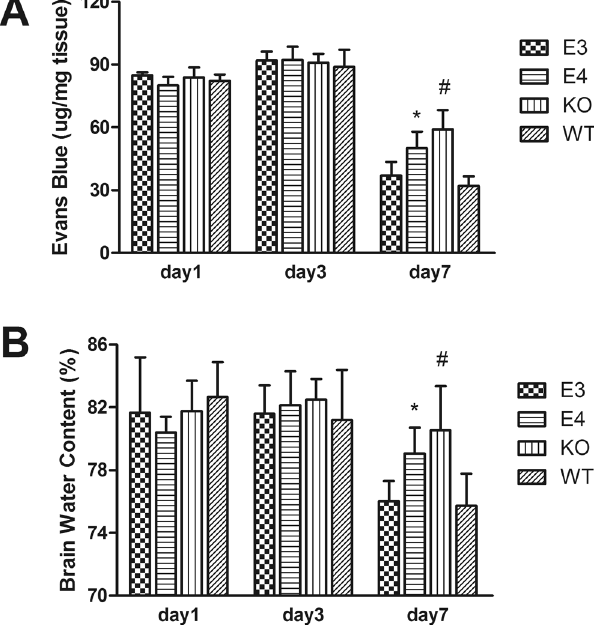
Figure 3. ( A ) BBB permeability was detected by EB extravasation after TBI, and no significant differences were observed in each group at day 1 or day 3. However, EB dye exudation significantly decreased in each group at day 7 and decreased more sharply in E3 and WT mice. ( * P < 0.05 vs E3 mice and P < 0.01 vs WT mice; # P < 0.01 vs WT mice. N = 8) ( B ) The brain water content significantly increased after injury. Consistent with the BBB permeability assay, at day 7 after injury, the water content was significantly higher in the brains of E4 mice compared with E3 and WT mice. Additionally, a significantly higher water content was observed in the KO group than in the WT group. ( * P < 0.05 vs WT mice and E3 mice; # P < 0.05 vs WT mice. N = 8). The data are presented as the mean ±